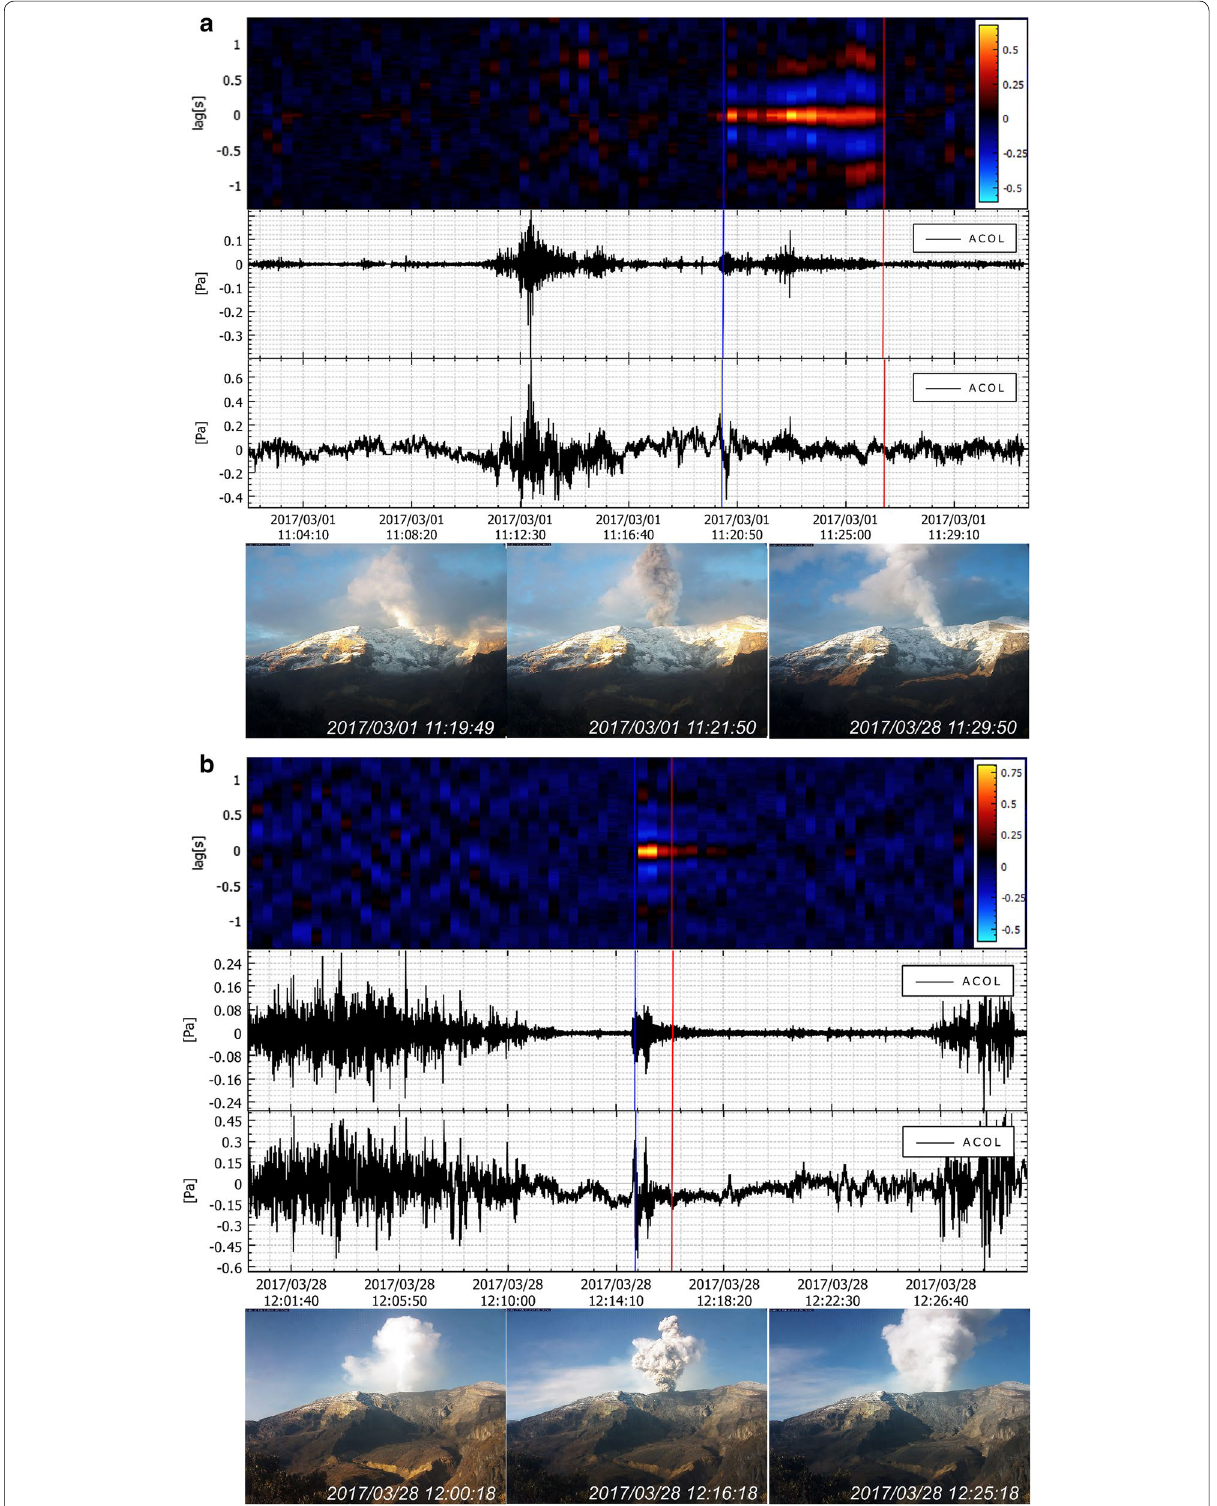
Fig. 5 Examples of infrasound signals (the cross‑correlation pattern and filtered/unfiltered wave traces from the Chaparral sensor) at ACOLM station compared with photo images at PIRAÑA‑AZUFRADO (Pir‑Azu in Fig. 1a) camera. Ash emission events on March 1, 2017, at 11:20 (UTC) ( a ), and on March 28, 2017, at 12:15 (UTC) ( b